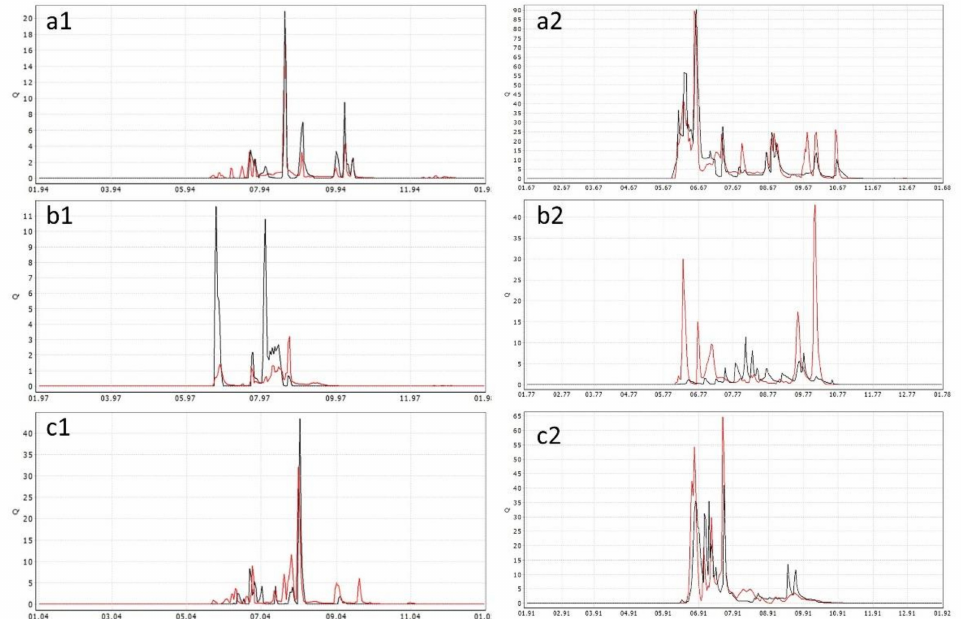
Figure 4. Observed (black) and simulated (red) streamflow hydrographs; 1 —Sakharynia, 2 —Artyk- Yuryah; ( a – c )—high, low and average NS criteria.